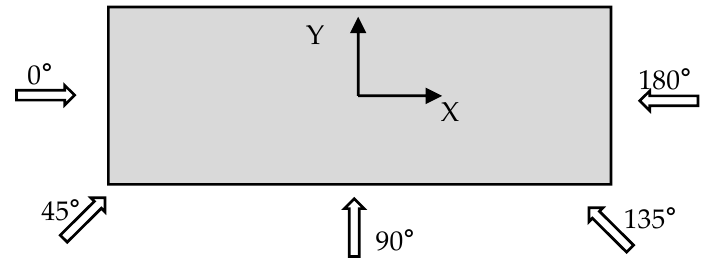
Figure 4. Top view of the hydrodynamic model and the incidence angle of waves.